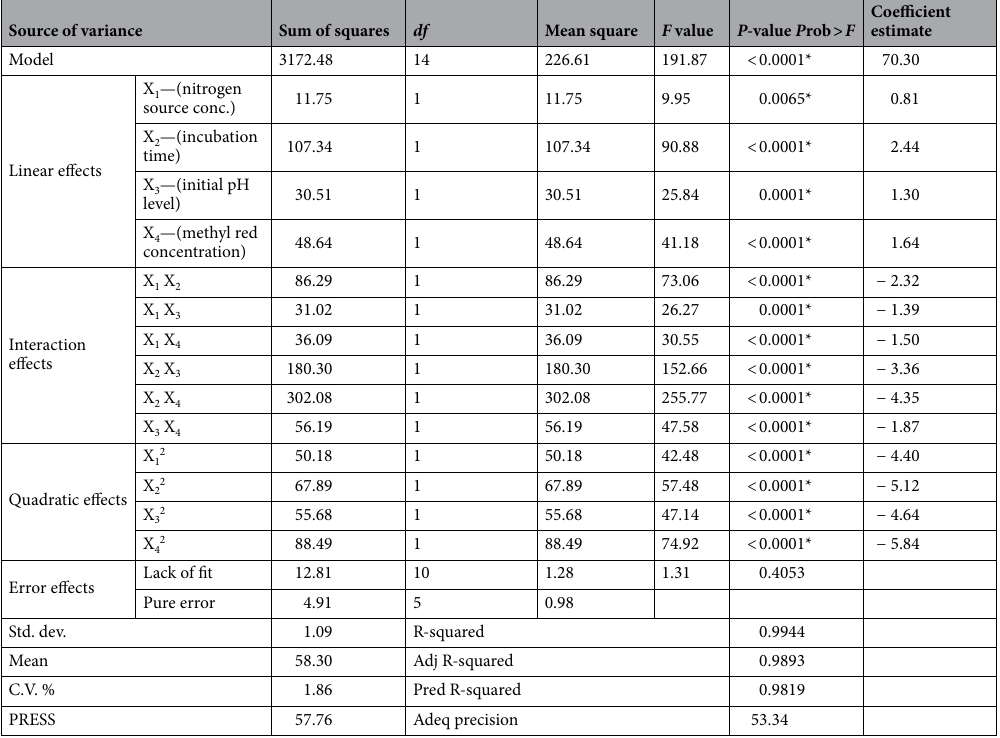
Table 2. ANOVA for FCCCD results for methyl red decolorization (%) by using Scenedesmus obliquus